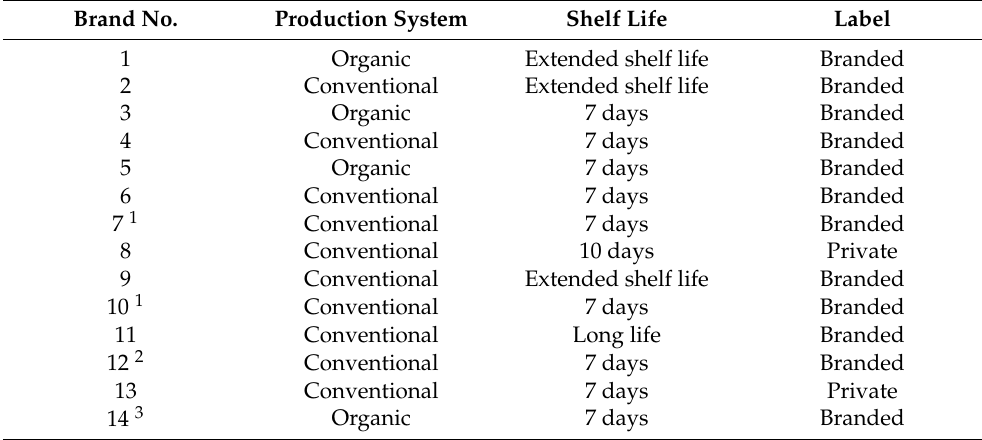
Table 2. Characteristics of milk samples. Brand No. Shelf Life